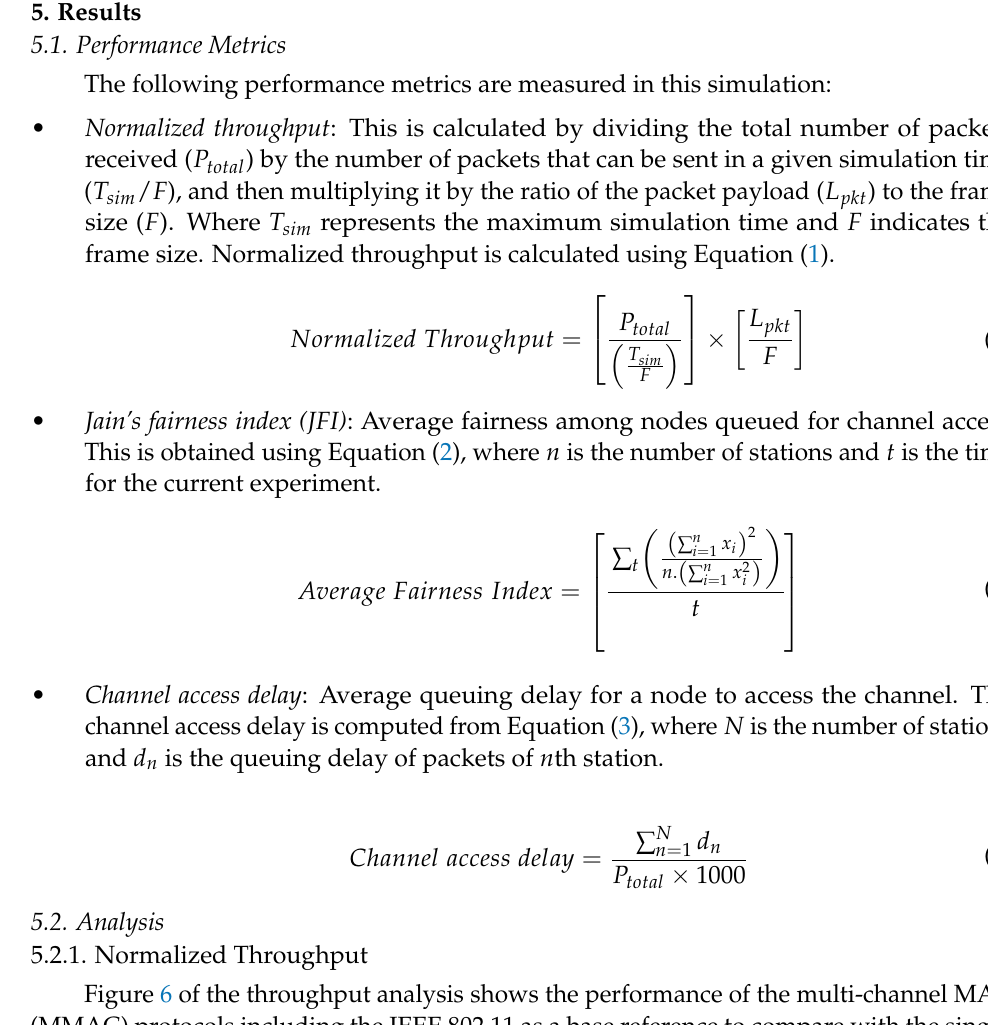
Figure 5. Simulation of IEEE 802.11, AMMAC, BiMMAC, and